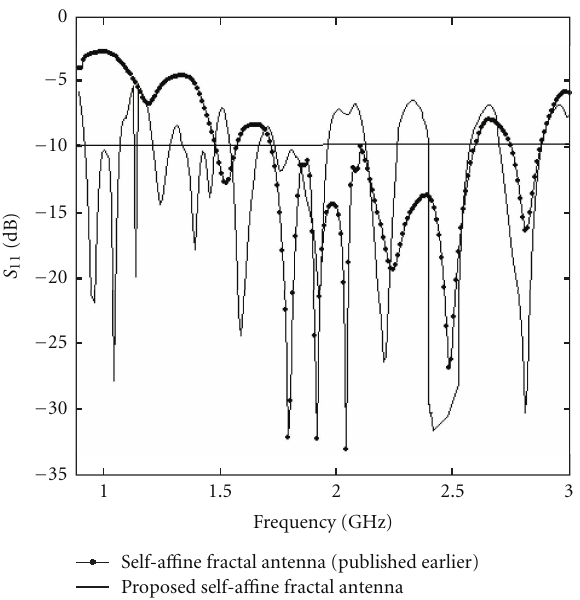
Figure 8: Performance comparisons of measured S 11 parameter between self-a ffi ne fractal